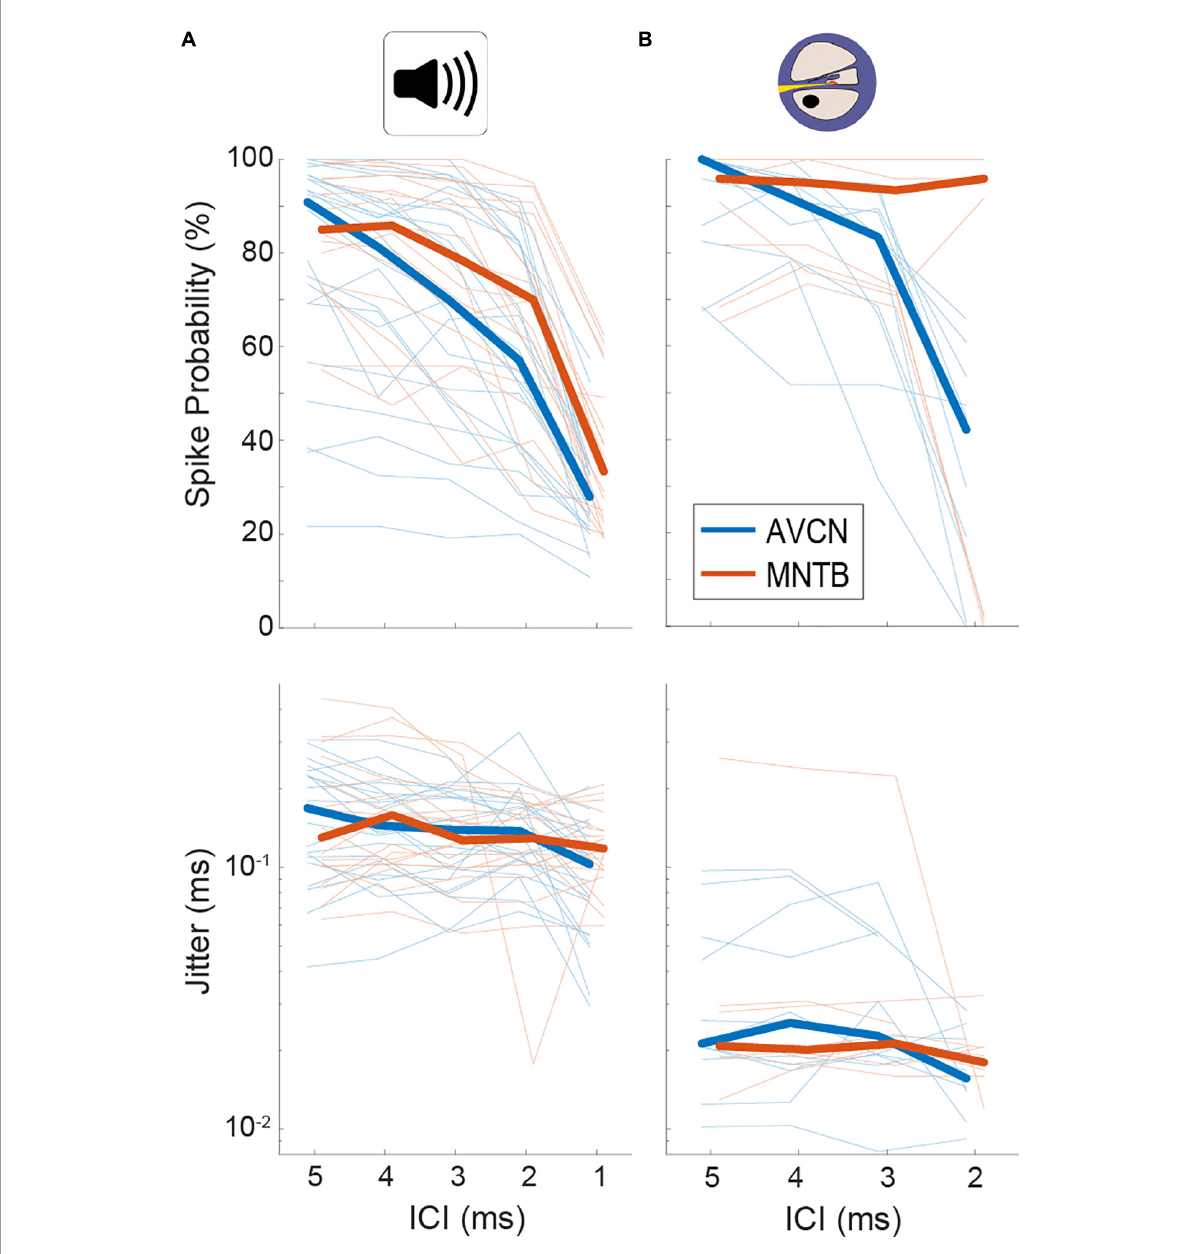
FIGURE2 Quantification of spiking probability (upper row) and precision (lower row) in gerbil antero-ventral cochlear nucleus (AVCN) and medial nucleus of the trapezoid body (MNTB) in response to acoustic (A) and electrical (B) click train stimulation. Plotted are average values for each recorded neuron (thin lines) and the sample medians (bold lines). See also Table 1